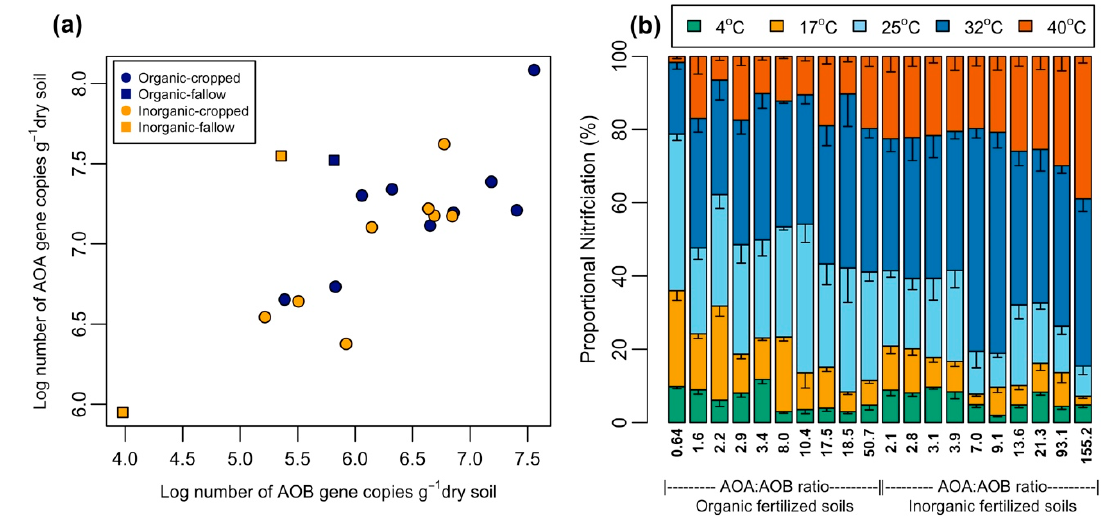
Figure 1. The variation ( a ) in ammonia oxidizing archaea (AOA) and ammonia oxidizing bacteria (AOB) abundances (qAOA and qAOB, respectively) among organic and inorganic farm and influence of AOA to AOB ratios ( b ) on soil proportional nitrification across a temperature range of 4 to 40 ◦ C. Error bars represent the standard error ( n = 3) for nitrification potential at each